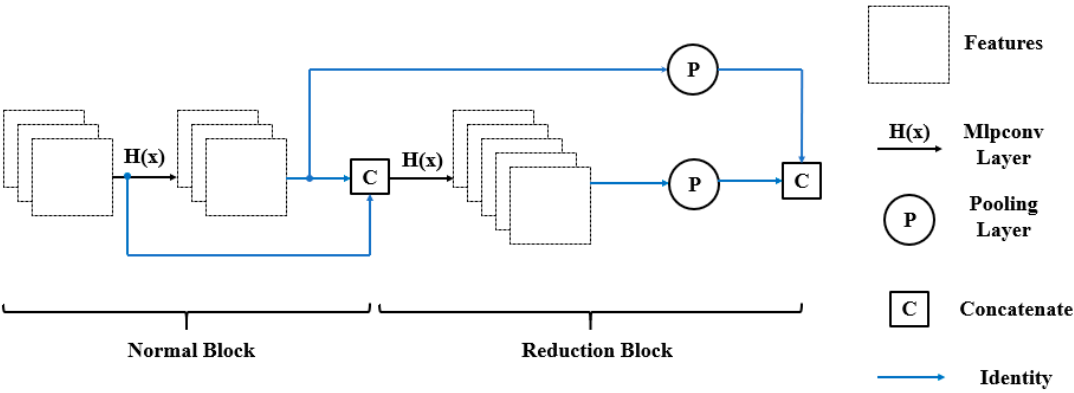
Figure 5. Connection across building blocks.